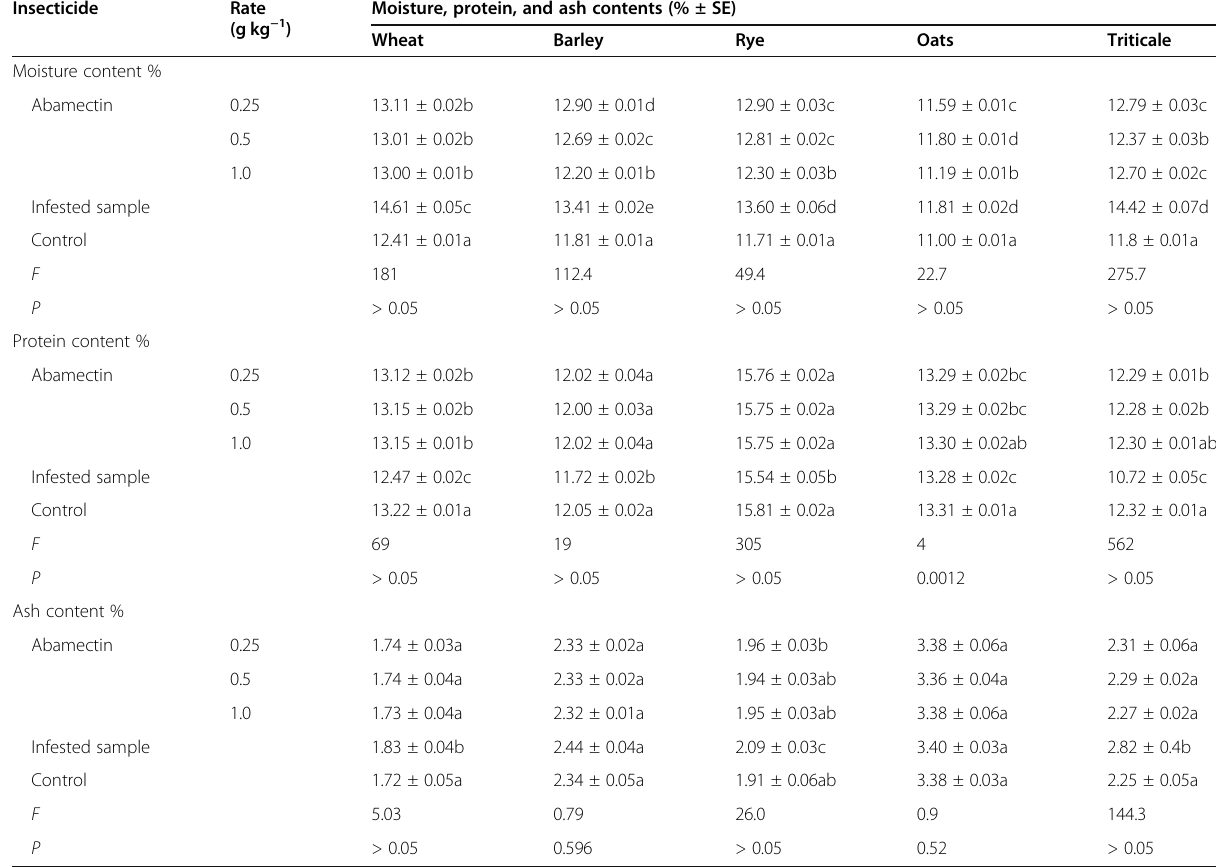
Table 5 Moisture, protein, and ash contents in 5 grain species treated with abamectin after Rhyzopertha dominica progeny count Insecticide Moisture content %